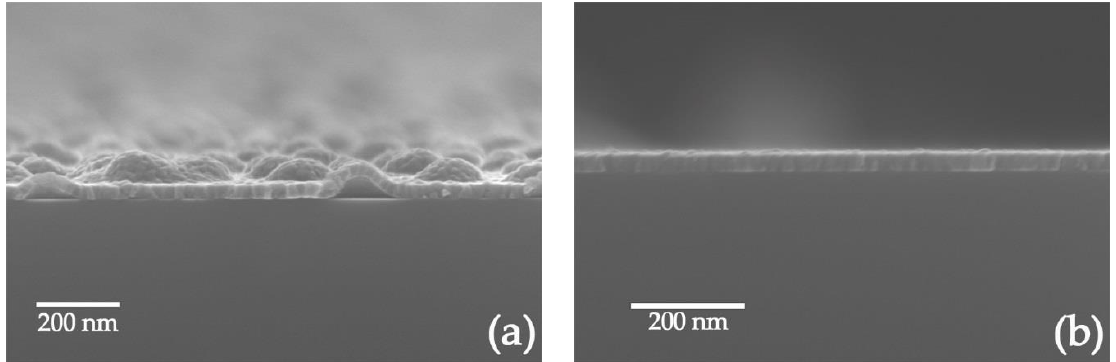
Figure 4. SEM image of ruthenium film on Silicon ( a ) and SiO 2 (850 nm)/Si ( b ) substrates. Coatings 2021 , 11 , x FOR PEER REVIEW Mechanical stress data are also consistent with the roughness of the films. According to the AFM data, the samples with silicon substrates have a very high surface roughness (RMS = 17.1 nm), due to the formation of blisters (Figure 5a). On samples where there is